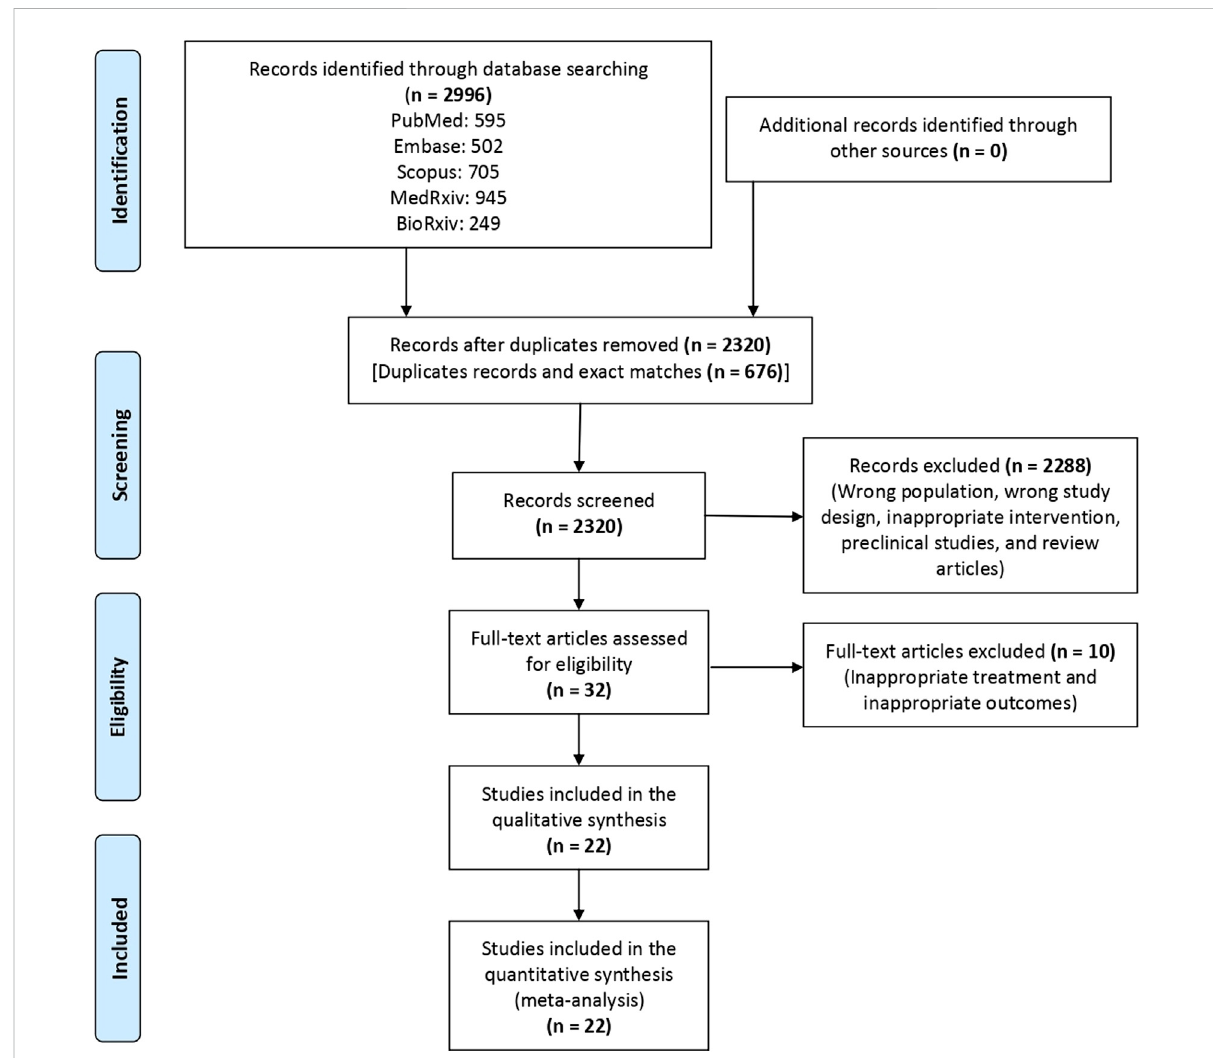
Study fl ow chart depicting the steps of the synthesis of evidence from the